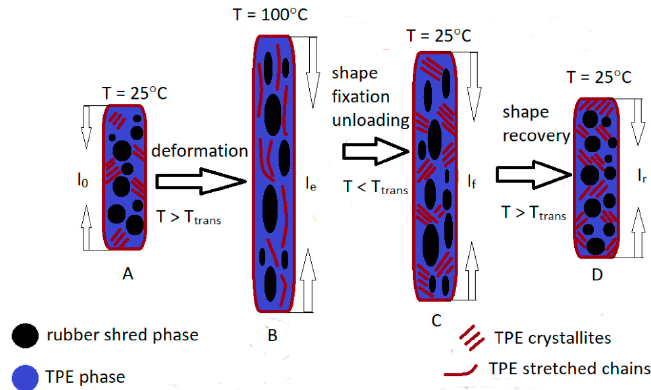
Figure 10. Schematic representation of sample deformation during shape memory tests.